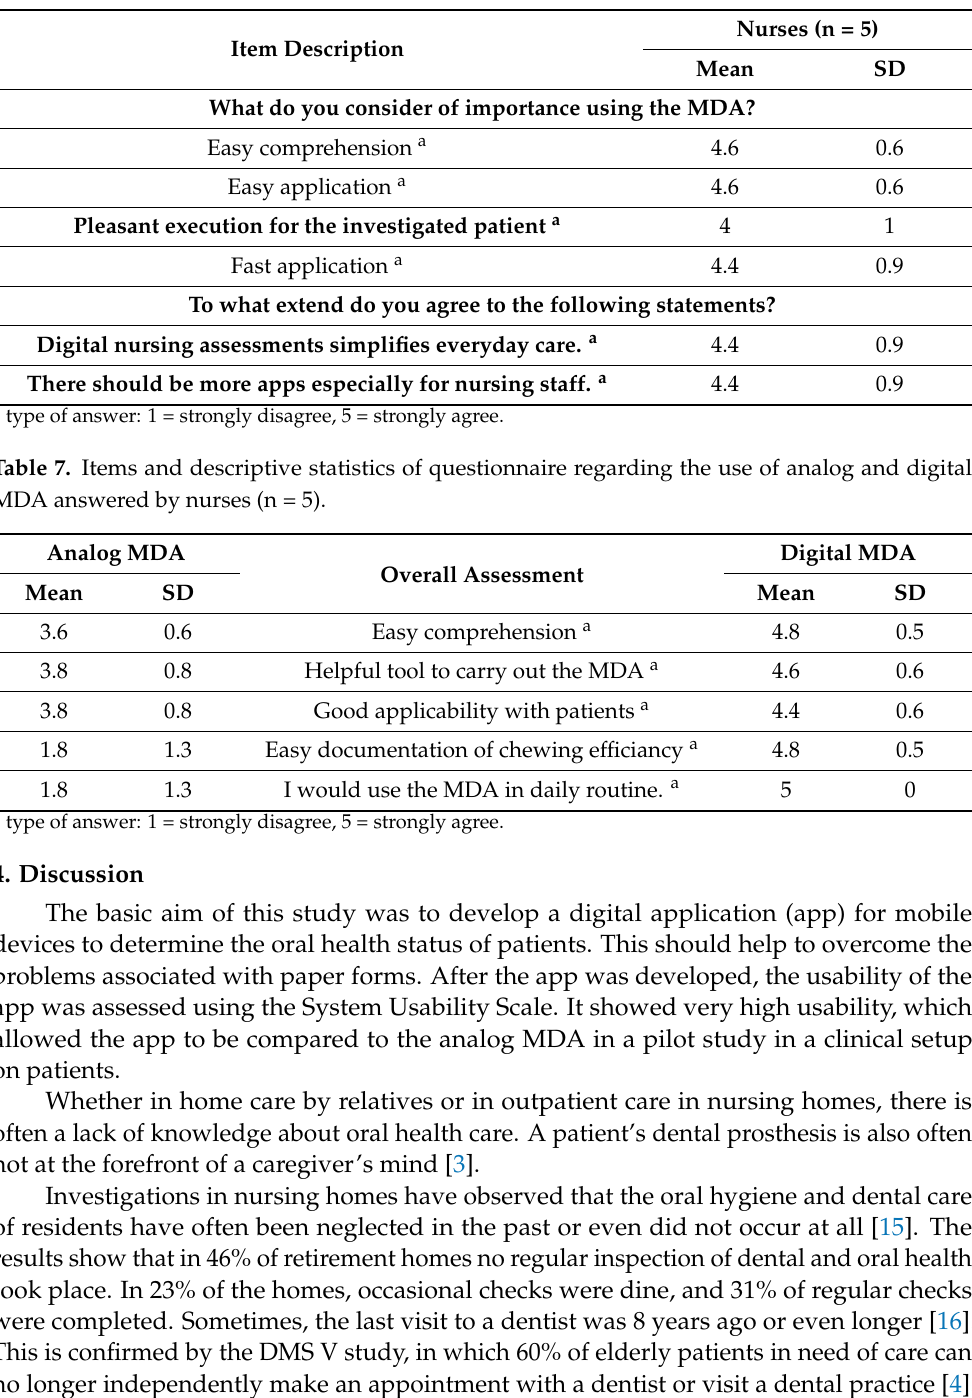
Table 6. Items and descriptive statistics of questionnaire regarding attitude towards MDA in general.